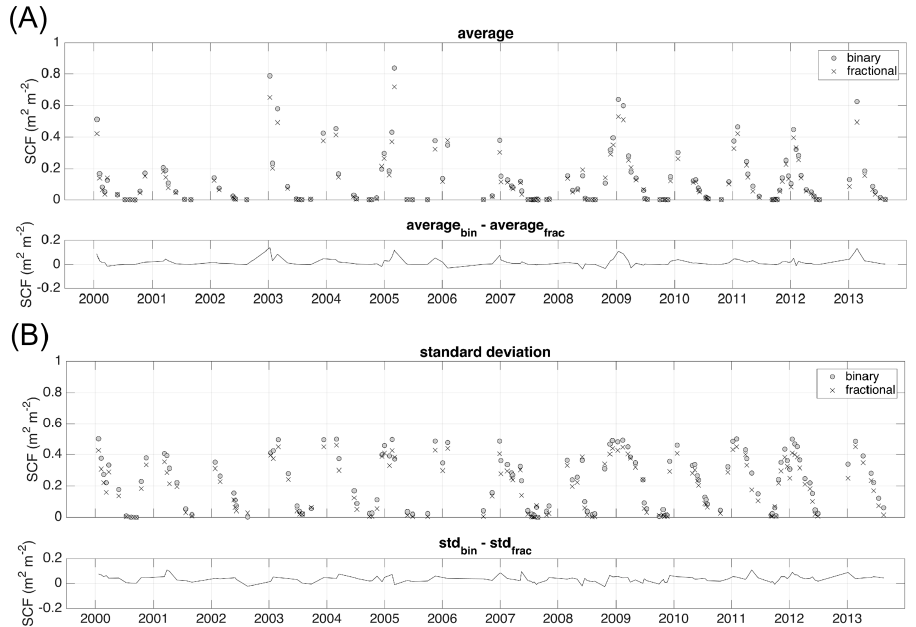
Figure 3. ( A ) Evolution of the averaged snow cover fraction in Sierra Nevada Mountain above the threshold altitude of 1000 m throughout the study period (2000–2013) from both binary (grey dots) and fractional (black crosses) algorithms, and ( B ) the associated standard deviation values, together with their difference.